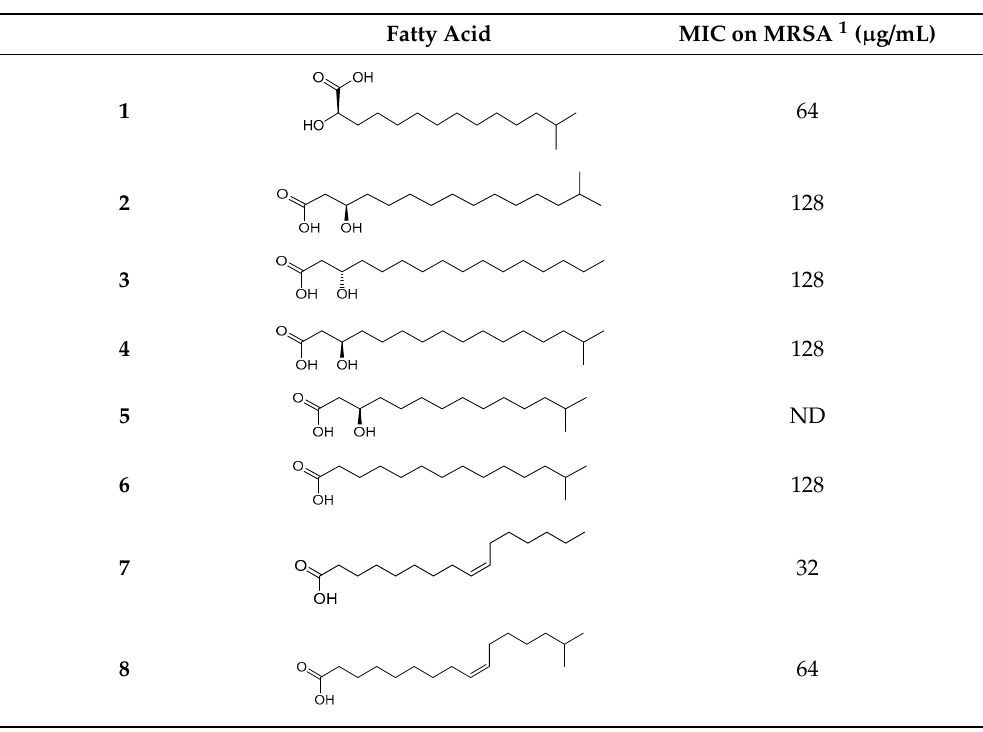
Table 1. Minimal Inhibitory Concentration (MIC) of compounds 1–8 against methicillin-resistant S. aureus .